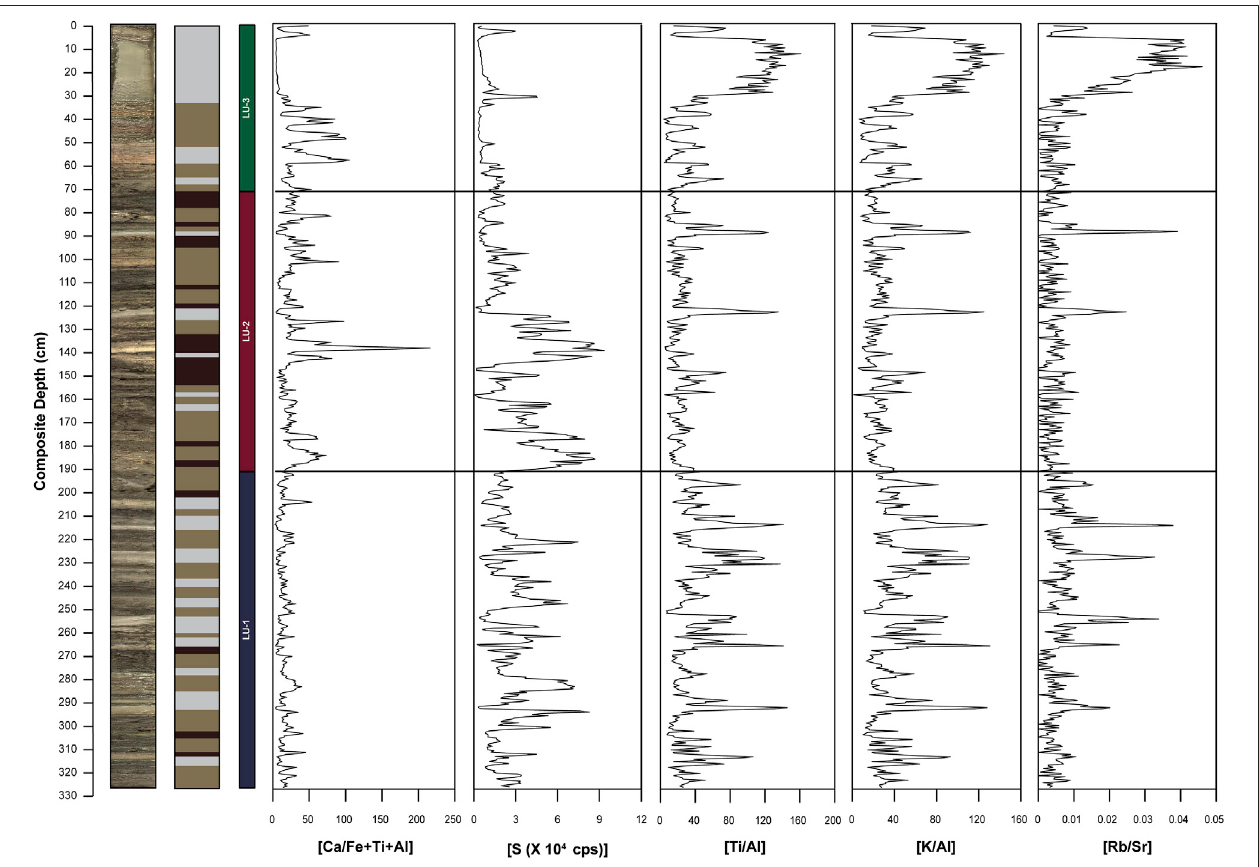
FIGURE4| MajorXRFdatapresentedinthepaperandcomparedwithahigh-resolutioncoreimageofGBW.TheelementalvariabilityofCa/(Al+Fe+Ti),Scounts, Ti/Al, K/Al, and Rb/Sr is shown (see text for more details).